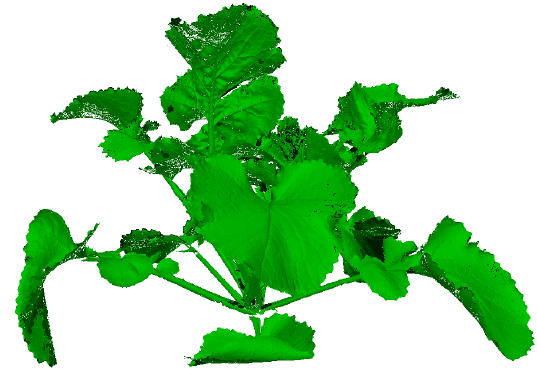
Figure 13. Sketch map of vertical layers of a rapeseed plant at the seedling stage.